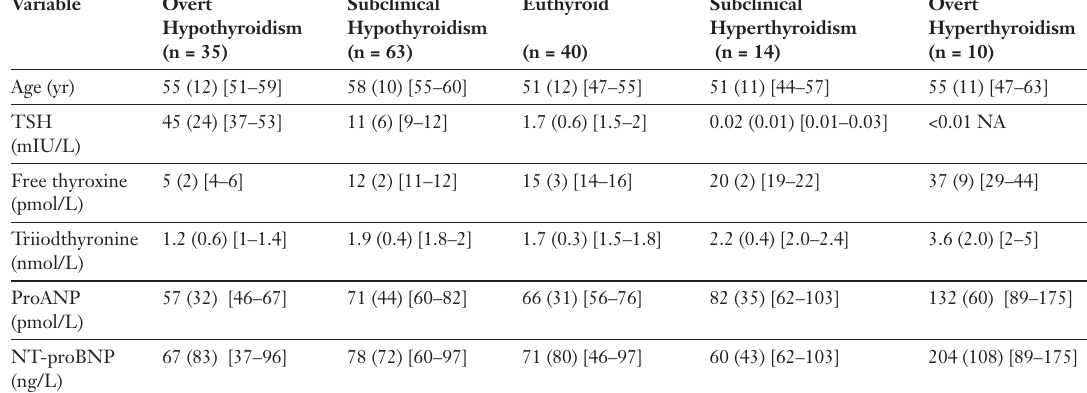
Characteristics of patients with various forms of thyroid dysfunction and of euthyroid controls.